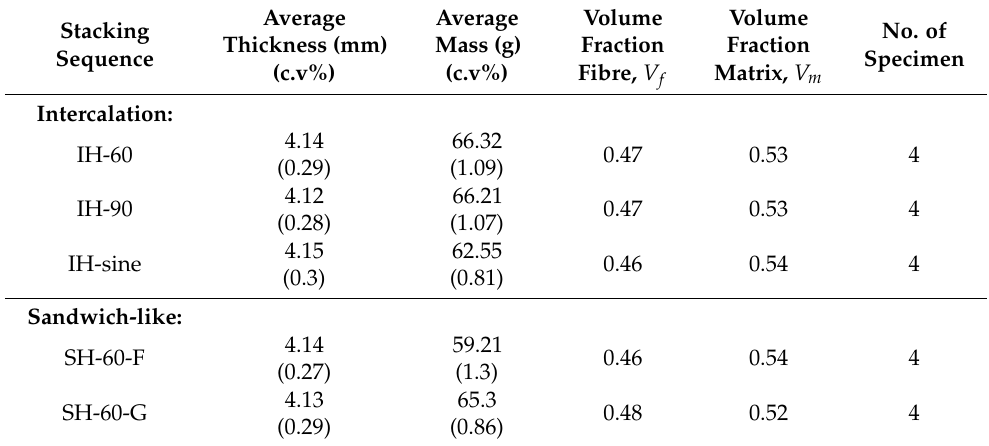
Table 2. Details of specimen